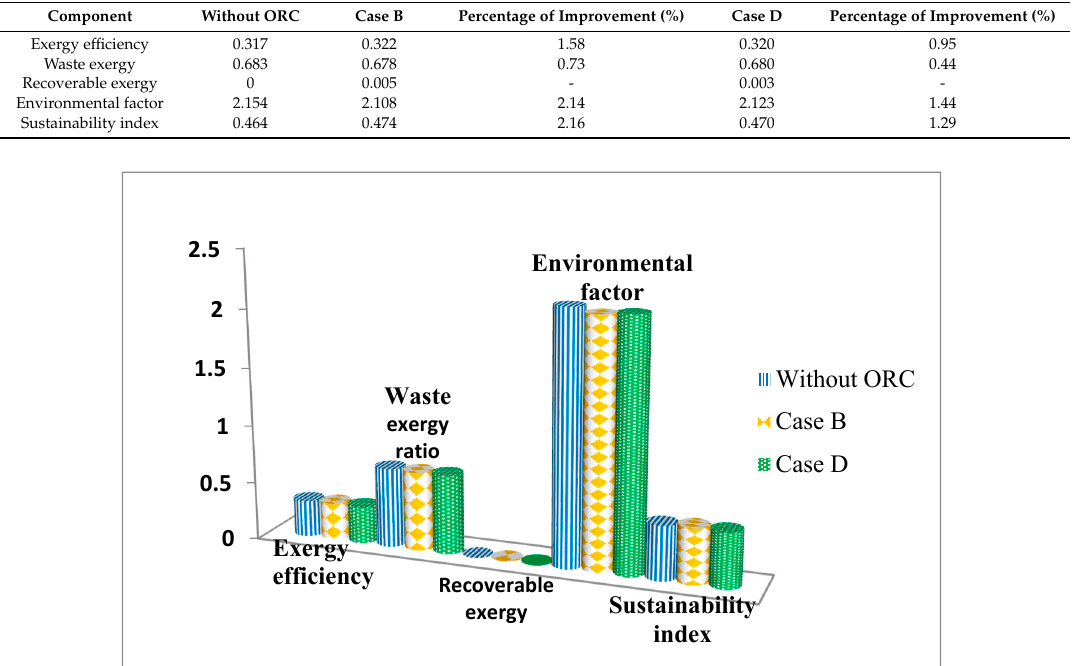
Figure 17. Exergetic sustainability factor of the engine with and without ORC